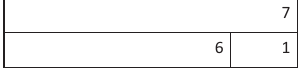
Whole-part-part diagram: A diagram depicting a whole and two parts of an additive relationship. This is a triad or number triple, where a context of length is